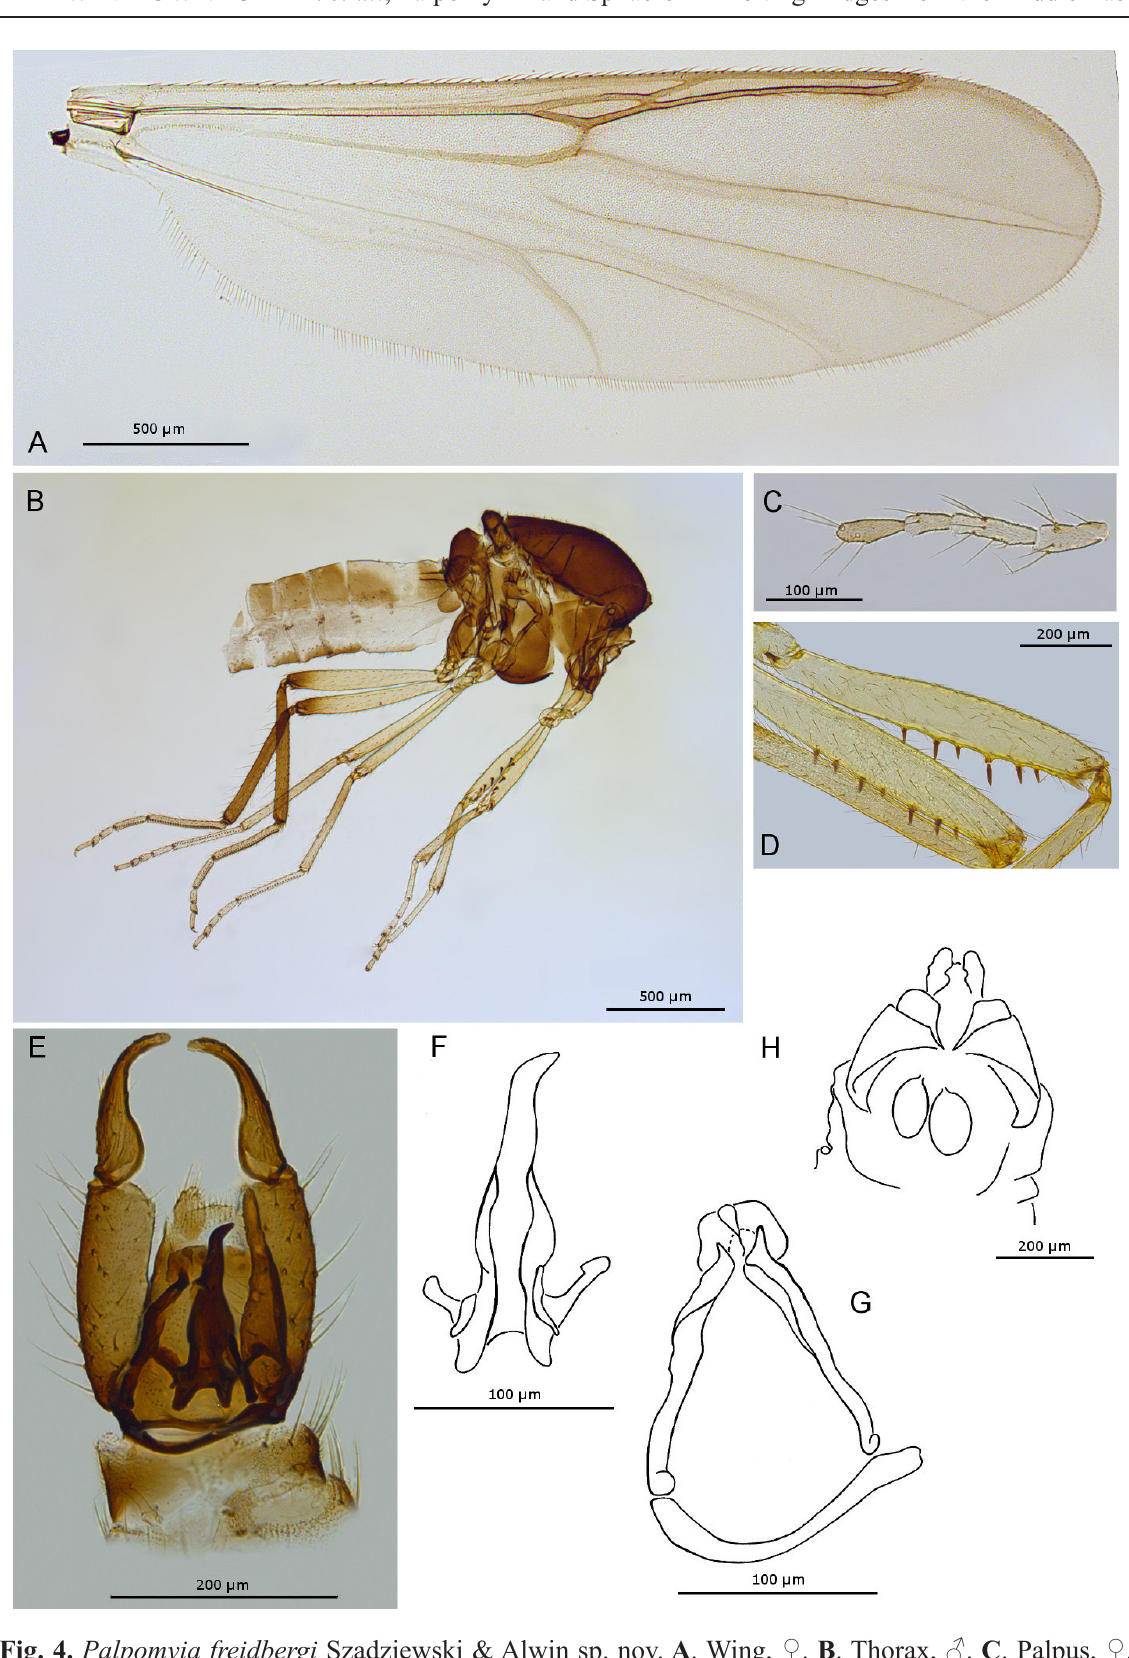
Fig. 4. Palpomyia freidbergi Szadziewski & Alwin sp. nov. A . Wing, ♀. B . Thorax, ♂. C . Palpus, ♀. D . Fore femur, ♀. E . Genitalia, ♂. F . Parameres. G . Aedeagus and sternite IX. H . Seminal